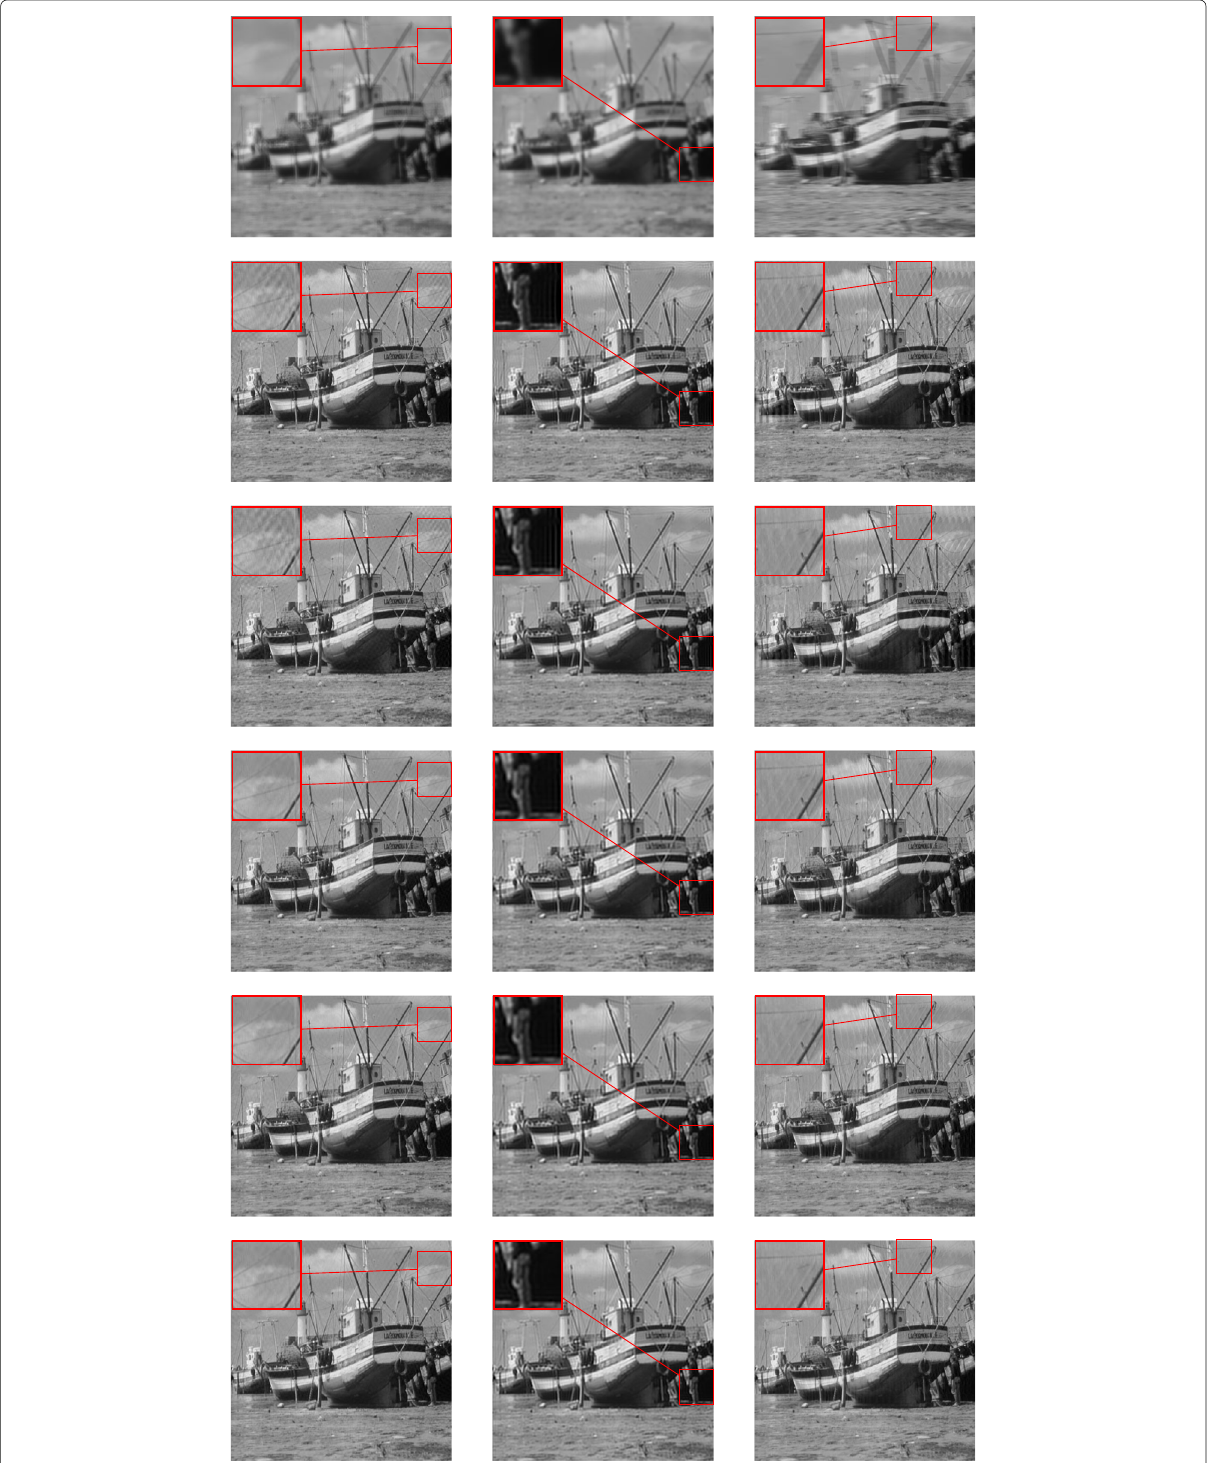
Fig. 8 Deconvolution of Boat image. From left to right, the first column represents degradation by kernel 1, the second column for the degradation by kernel 2, and by kernel 3 in the third column. From top to bottom, the order of the rows is as follows: blurred images using the three kernels respectively, restored images using RL algorithm [11] (kernel 1 (iterations = 150), kernel 2 (iterations = 330), and kernel 3 (iterations = 80)), restored images using Wiener filter [9], restored images using TV method [14], restored images using BTV approach [16], and finally the restored images using our proposed MAP- H 1